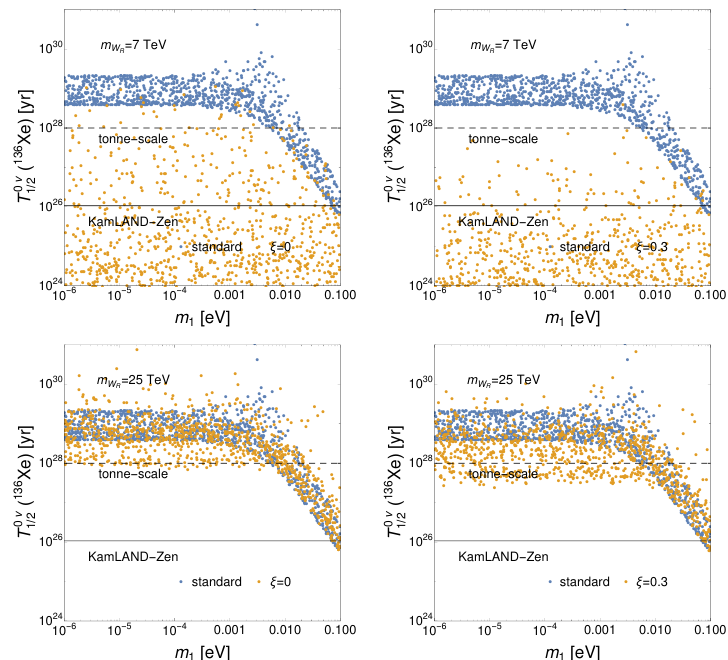
Figure 6. 136 Xe half-life as a function of the lightest neutrino mass m 1 in the type-I seesaw dominance scenario (orange). The active neutrinos are assumed to be in the NH, and the sterile neutrino masses are randomly chosen between 10 MeV to 1 TeV. The right-handed gauge boson mass is set to be m = 7 TeV and 25 TeV in the upper and lower panels for ξ = 0 (left) and 0 . 3 W R (right). For comparison, the predicted half-life in the standard mechanism is also shown (blue). The solid and dashed black lines denote the current and expected limits,